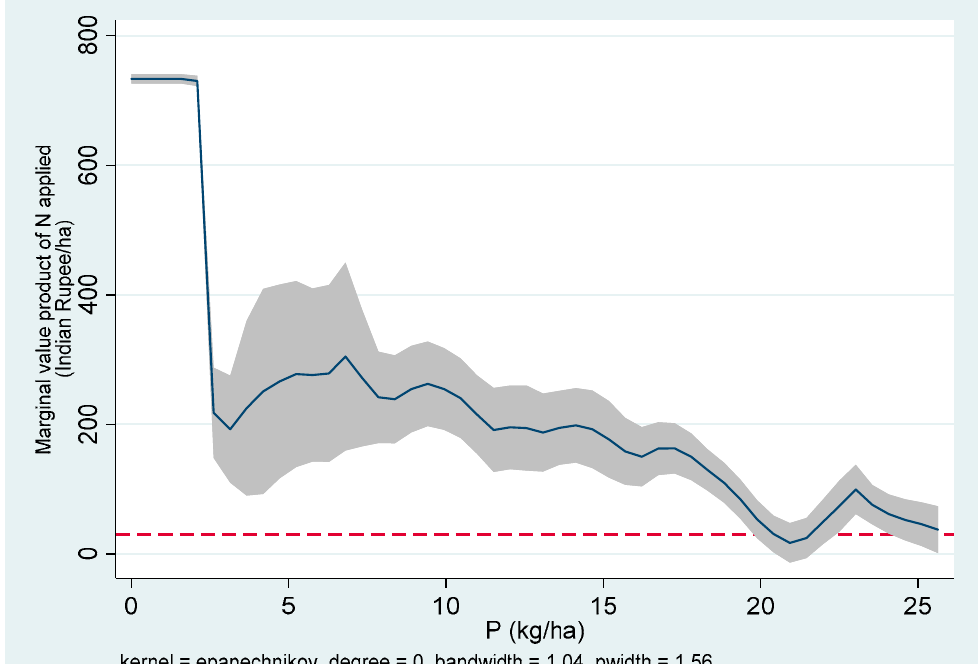
Figure 7. Marginal value product of N ( MVP N ) and P applied in Aduthurai, India.